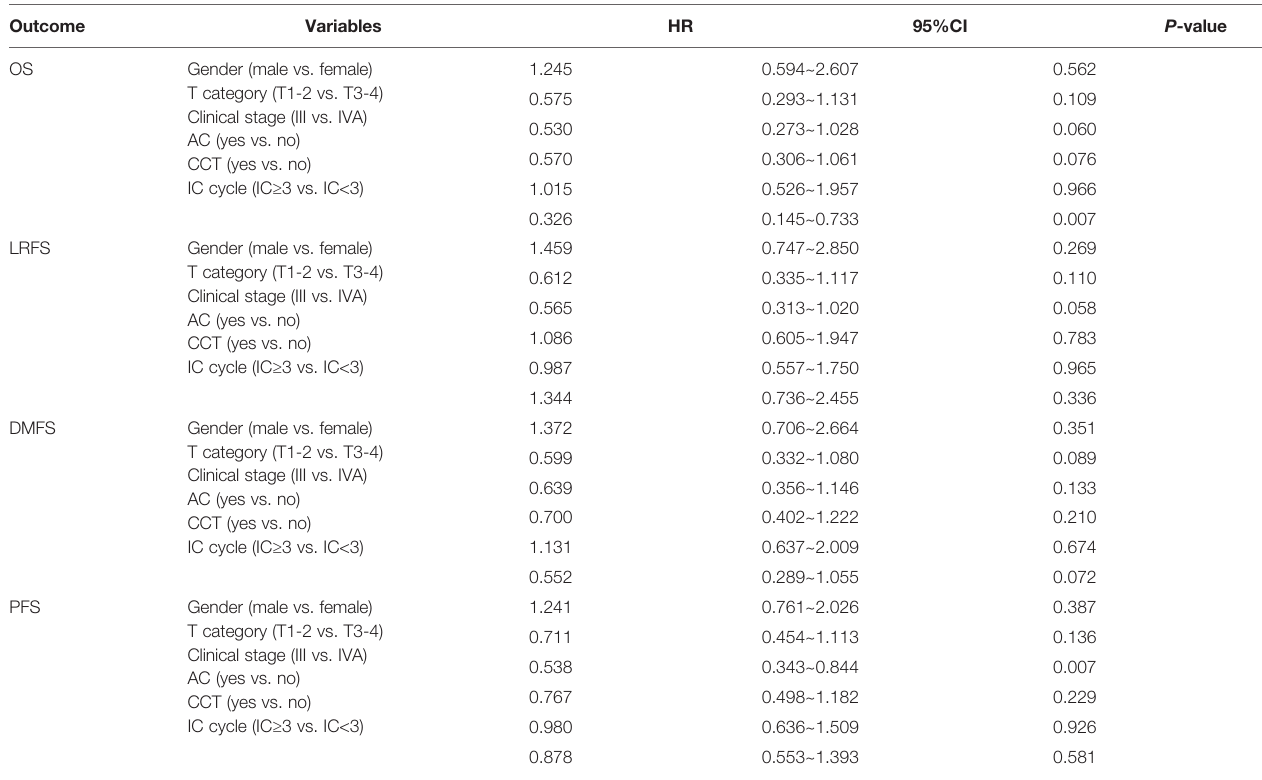
TABLE 3 | Multivariate Cox regression analysis for all patients. Outcome Variables HR 95%CI P -value OS Gender (male vs. female) T category (T1-2 vs. T3-4) Clinical stage (III vs. IVA) AC (yes vs. no) CCT (yes vs. no) IC cycle (IC ≥ 3 vs. IC<3) LRFS Gender (male vs. female) T category (T1-2 vs. T3-4) Clinical stage (III vs. IVA) AC (yes vs. no) CCT (yes vs. no) IC cycle (IC ≥ 3 vs. IC<3) DMFS Gender (male vs. female) T category (T1-2 vs. T3-4) Clinical stage (III vs. IVA) AC (yes vs. no) CCT (yes vs. no) IC cycle (IC ≥ 3 vs. IC<3) PFS Gender (male vs. female) T category (T1-2 vs. T3-4) Clinical stage (III vs. IVA) AC (yes vs. no) CCT (yes vs. no) IC cycle (IC ≥ 3 vs. IC<3)